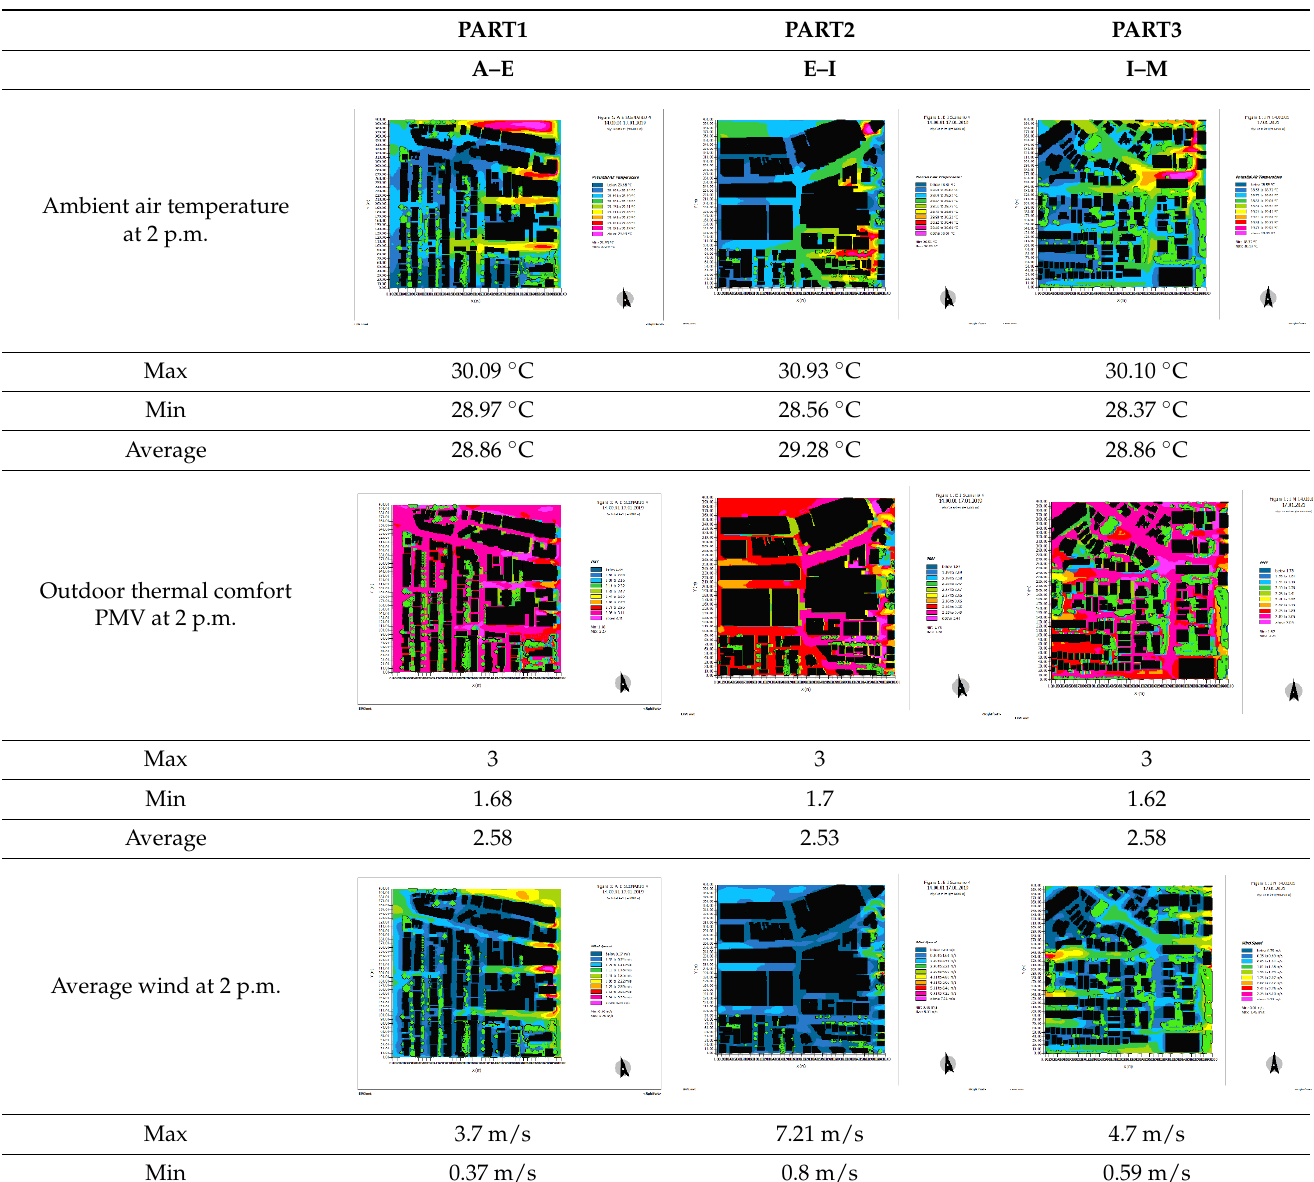
Table 11. Scenario four ambient air temperature, outdoor thermal comfort, and wind speed distri- bution maps in all parts at 14 pm.